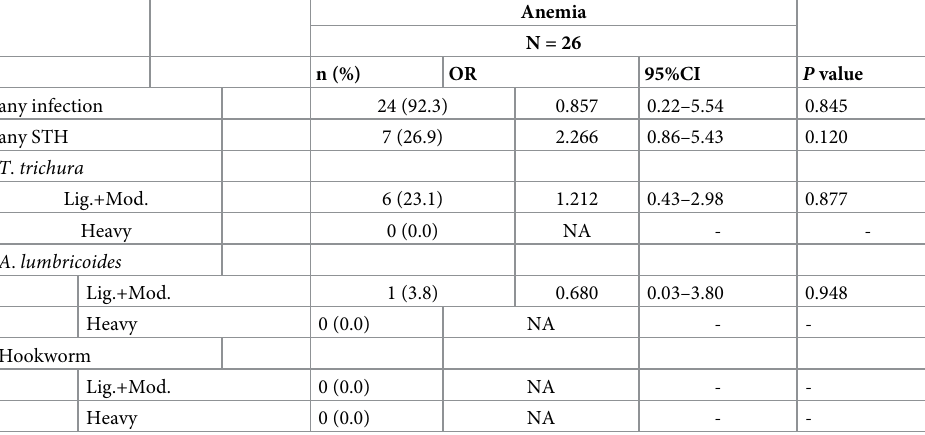
Table 5. Odds ratios for anemia in infected schoolchildren.